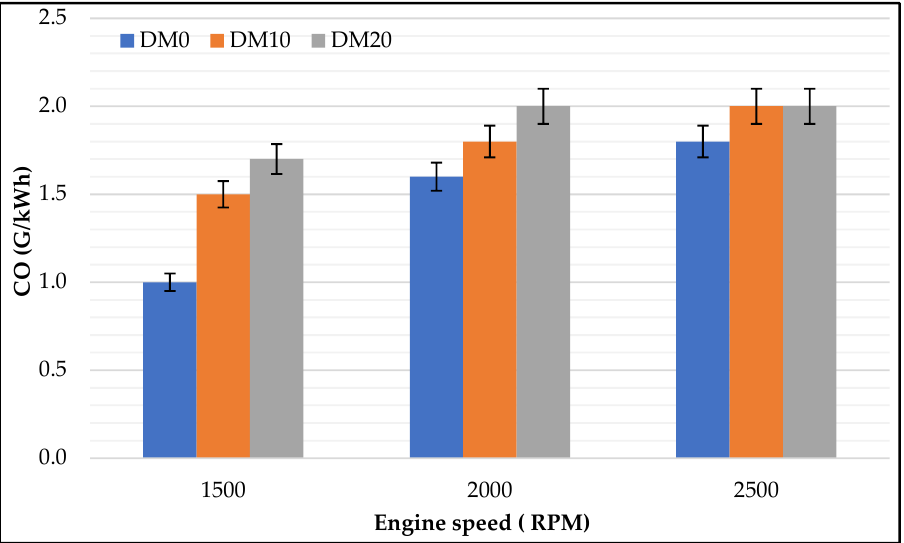
Figure 4. CO emissions at different engine speeds.